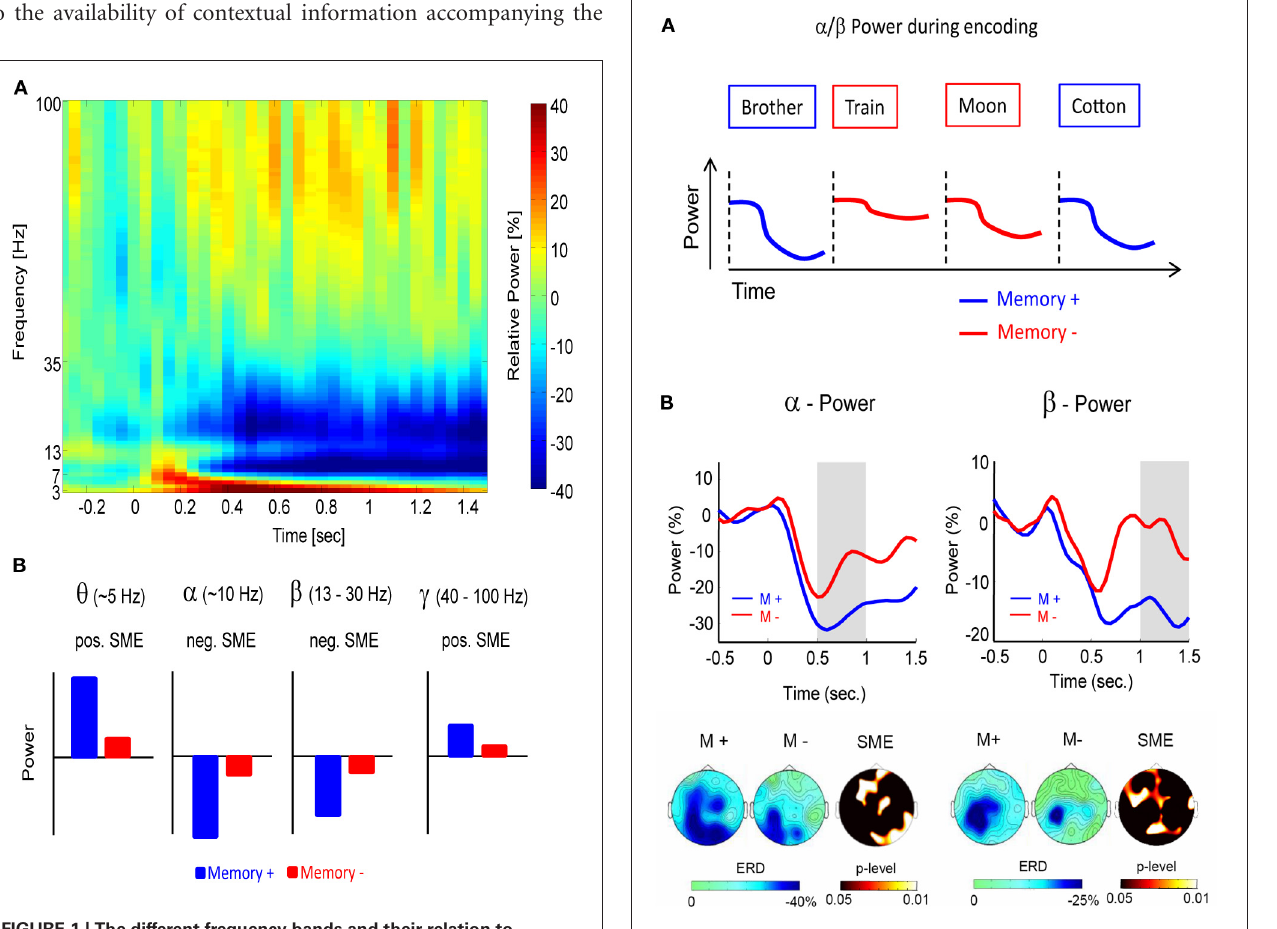
FIGURE 2 | Alpha/beta power during encoding. (A) Alpha/beta power decreases during encoding are more pronounced for words which are subsequently remembered (blue) than for words which are subsequently forgotten (red). (B) Alpha (left) and beta (right) SMEs are shown during deep (semantic) encoding. Negative SMEs were observed in both frequency bands from 500 to 1500ms after stimulus onset. The gray bars indicate the time windows for plotting the corresponding topographies (bottom). Figure adapted from Hanslmayr et al.